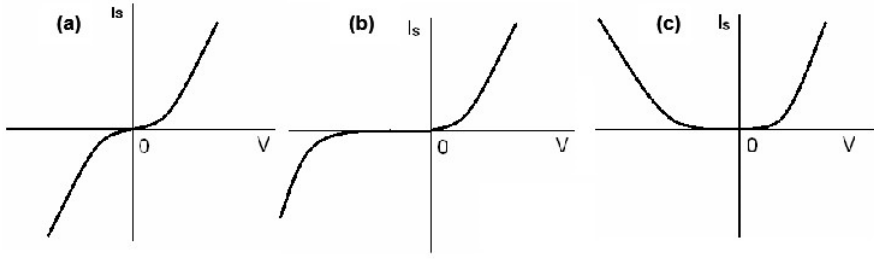
Figure 7. Spin rectification: ( a ) Symmetrical spin rectification; ( b ) parallel spin rectification and ( c ) anti-parallel spin current rectification.